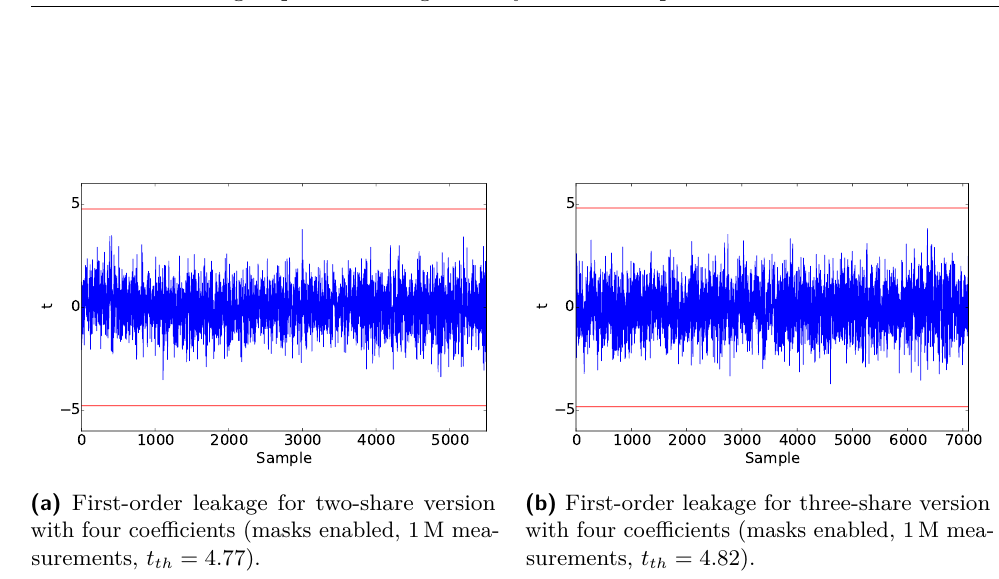
Figure 3: First-order SCA analysis of 2- and 3-share implementation.